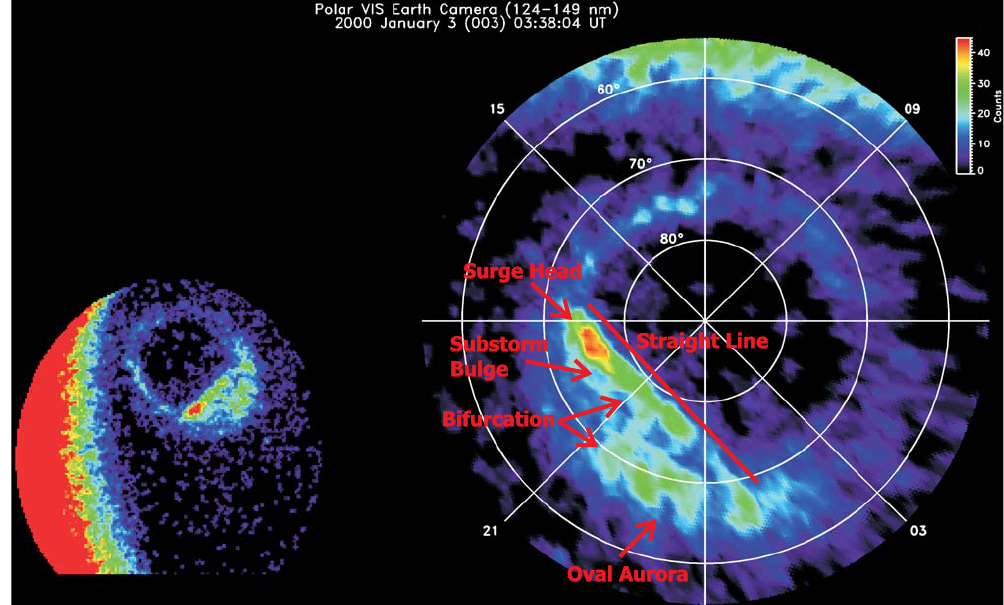
Fig. 2. A good example of an isolated classical auroral substorm event at the maximum of the expansion phase (from Gjerloev et al., 2007, Fig. 1), the original image on the left and a mapping to a magnetic local time (MLT), invariant latitude (ILat) coordinate system on the right. Key characteristics are labeled. Onset location was 69.0 ◦ ILat and 21.6MLT at